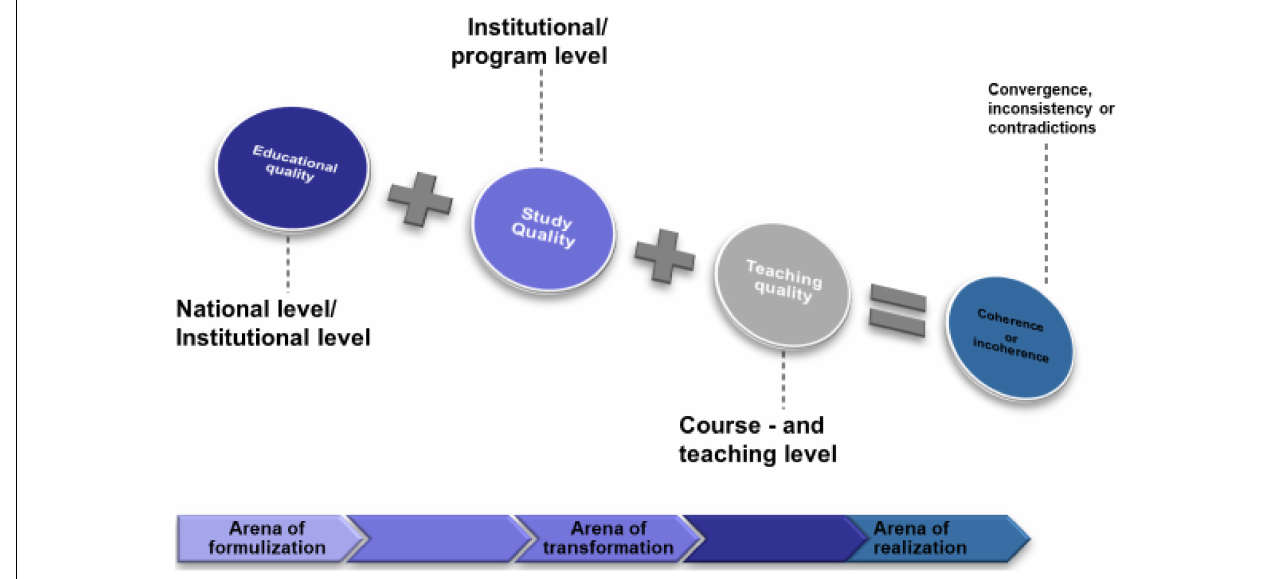
FIGURE 1 | The analytical focus in the case study (Krumsvik et al., 2019) is based on the frame factor theory (Linde, 2012; Lindensjö and Lundgren,